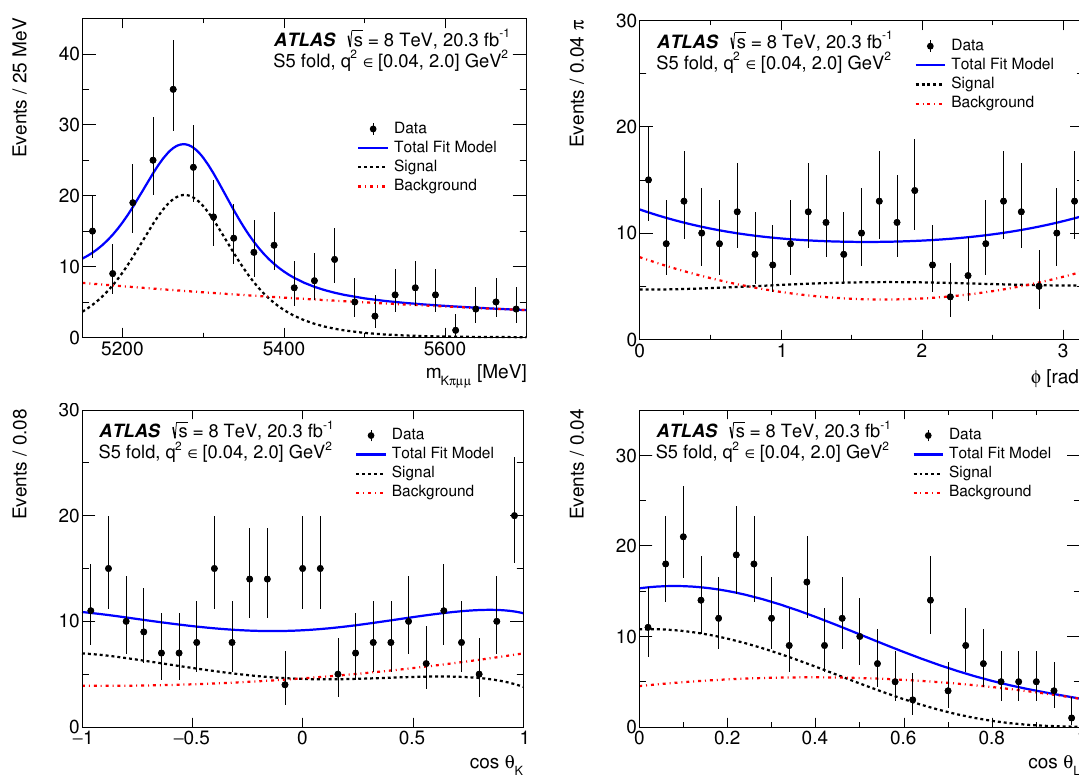
Figure 4 . The distributions of (top left) m , (top right) (cid:30) , (bottom left) cos (cid:18) , and (bottom K(cid:25)(cid:22)(cid:22) K right) cos (cid:18) obtained for q 2 2 [0 : 04 ; 2 : 0] GeV 2 . The (blue) solid line is a projection of the total L pdf, the (red) dot-dashed line represents the background, and the (black) dashed line represents the signal component. These plots are obtained from a (cid:12)t using the S folding scheme. 5